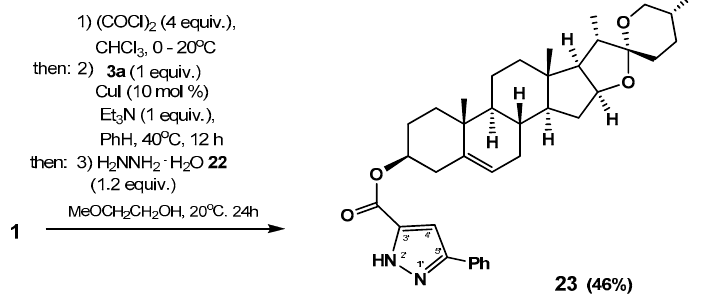
Figure 4. The molecular structure of pyrazole 23 . The thermal ellipsoids are drawn at the 30% probability level.